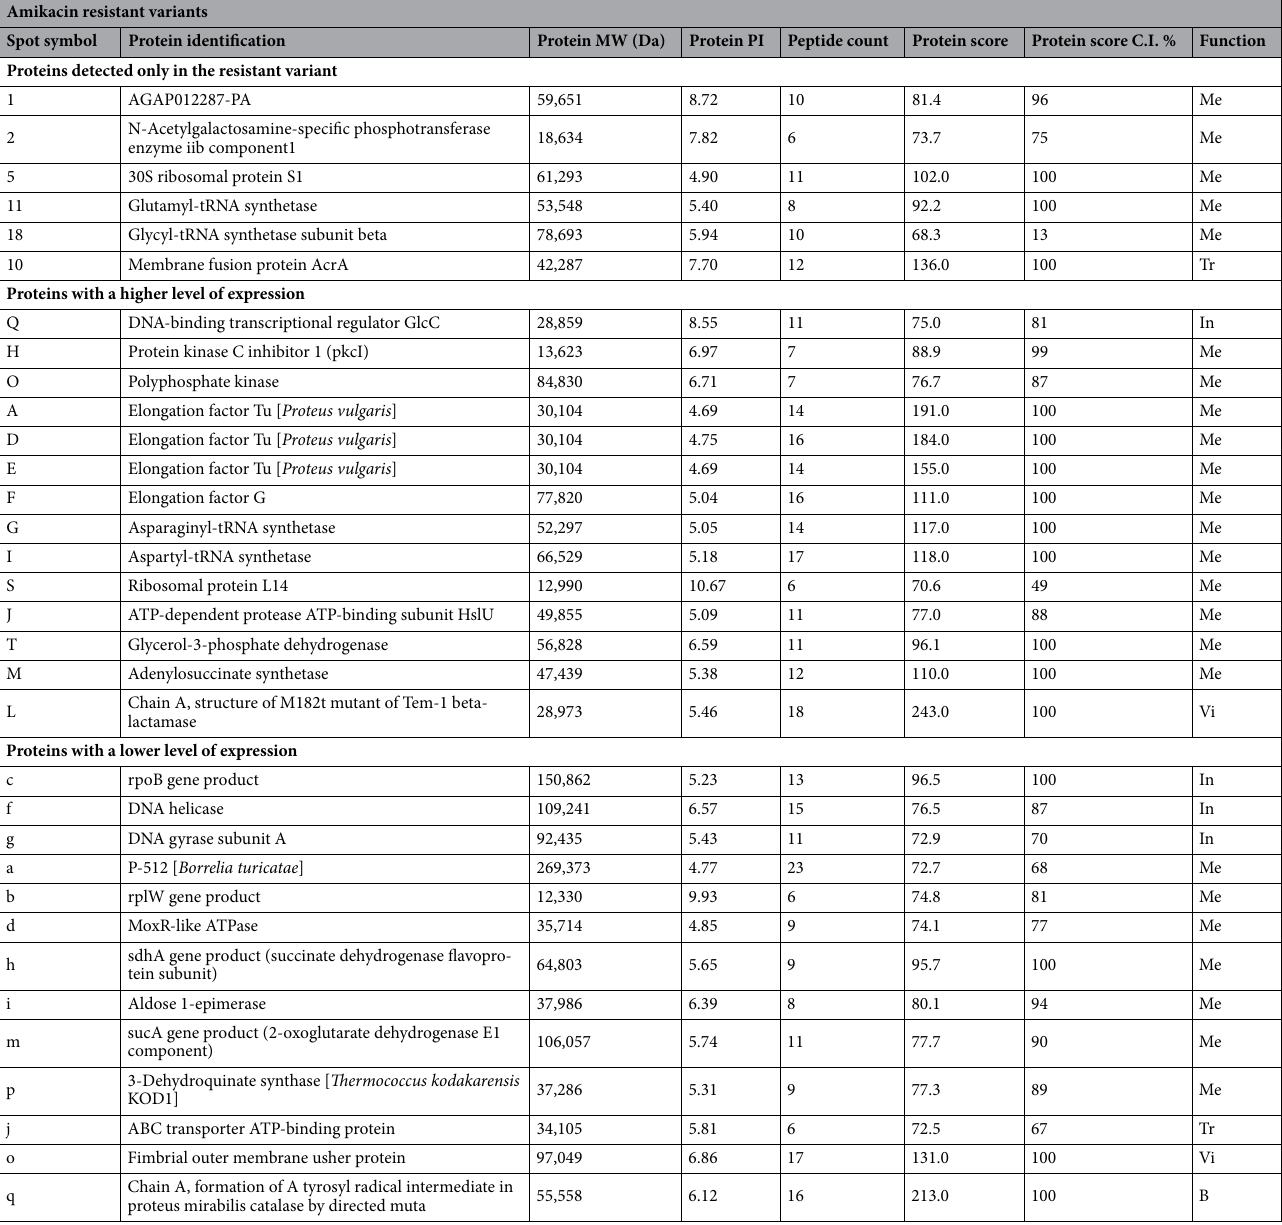
Table 2. Description of proteins specific to studied P. mirabilis 3059 amikacin resistant variant (AMKrsv) identified by MALDI TOF MS/MS. Protein function: In information pathways, Me metabolism, Tr transport, Vi virulence, Ch chaperone. Spots marked with numbers indicate proteins which were detected only in the studied resistant variants. Spots marked with capital or lowercase letters correspond to proteins with a higher or lower level of expression in the resistant variants,